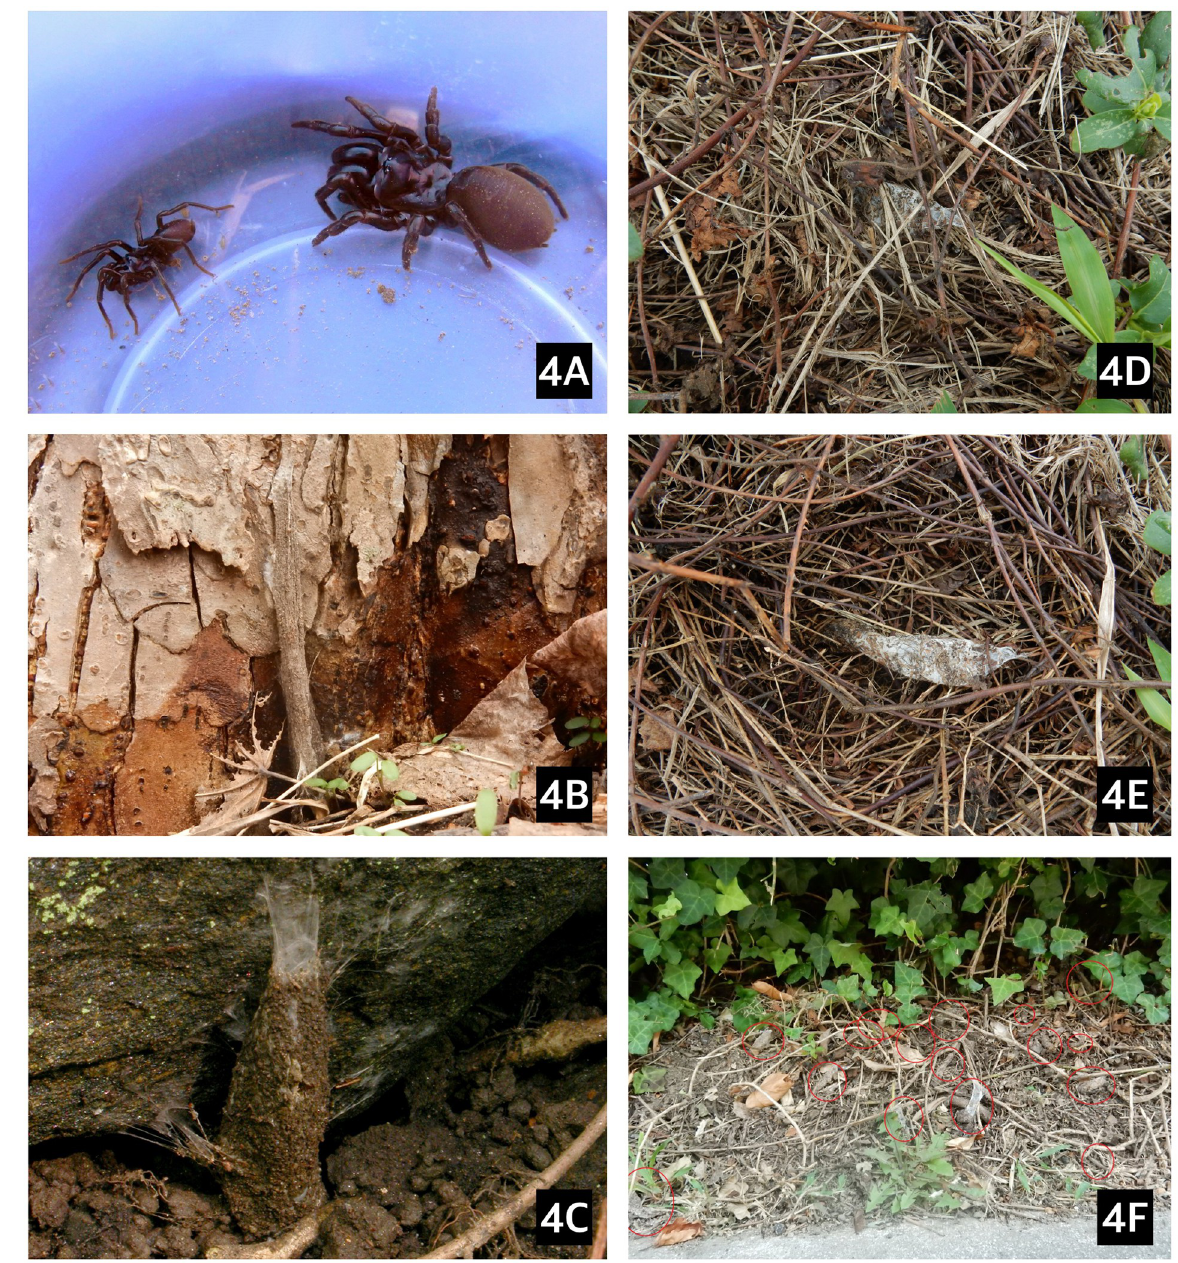
Fig 4. A . karschi and its webs in Pennsylvania, USA, (4A) adult female and male (on the left), (2B) vertical web attached to the base of a tree and (4C) to a boulder, (4D) horizontal web covered in thatch (4E) and with thatch removed, (4F) a detail of recently trimmed ivy in front of the same bushes shown in Fig 3A, with 16 purse-webs